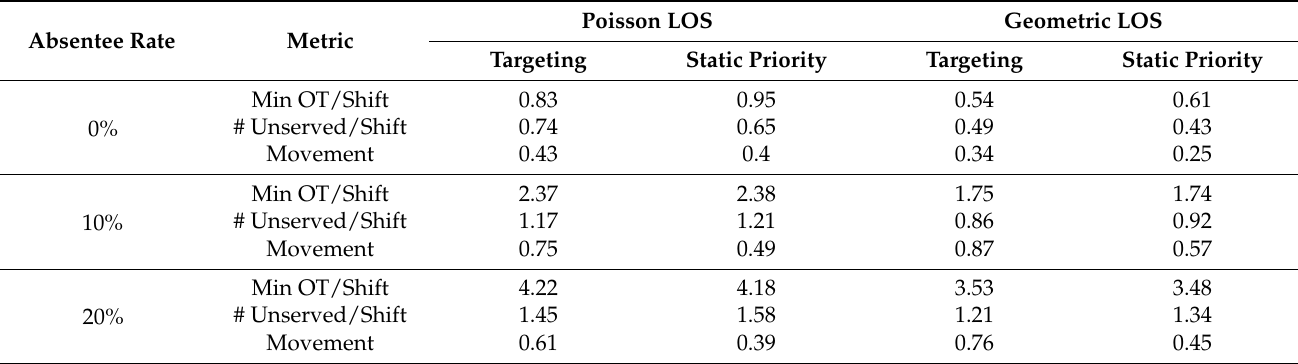
Table 5. The relative performance of targeting versus static priority